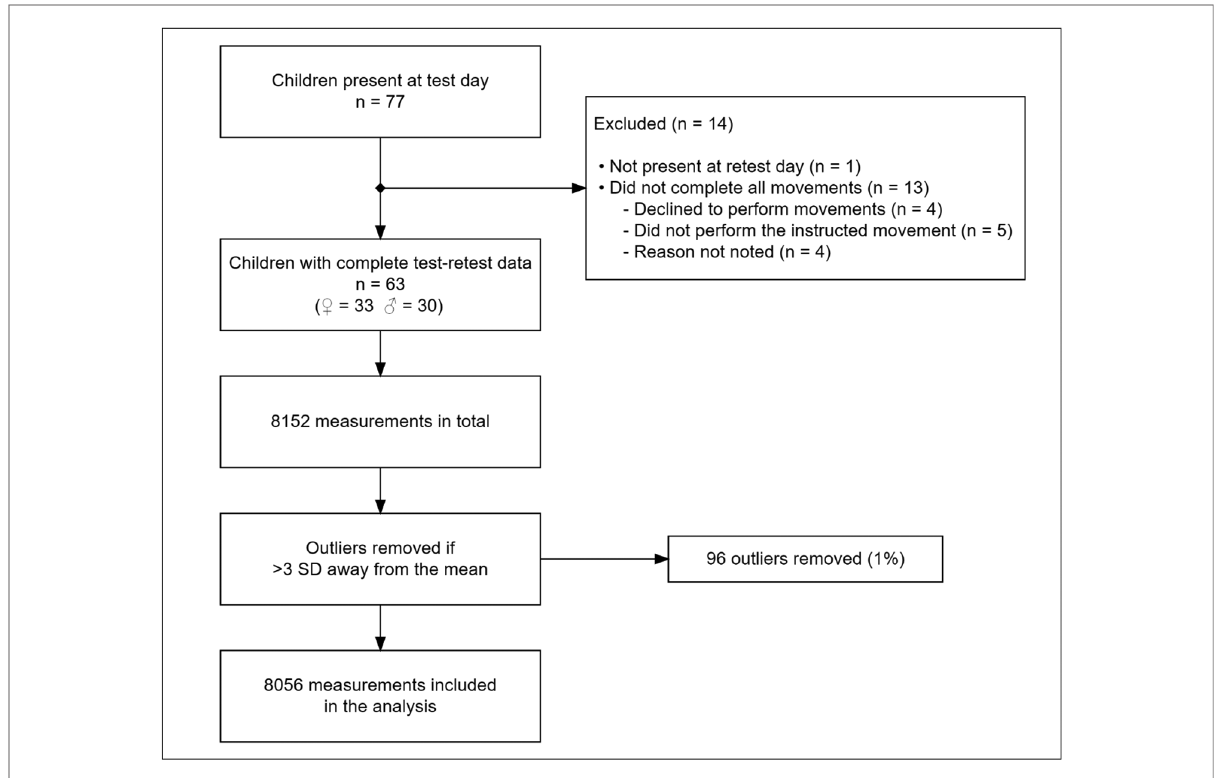
FIGURE 2 Flowchart of eligible subjects and